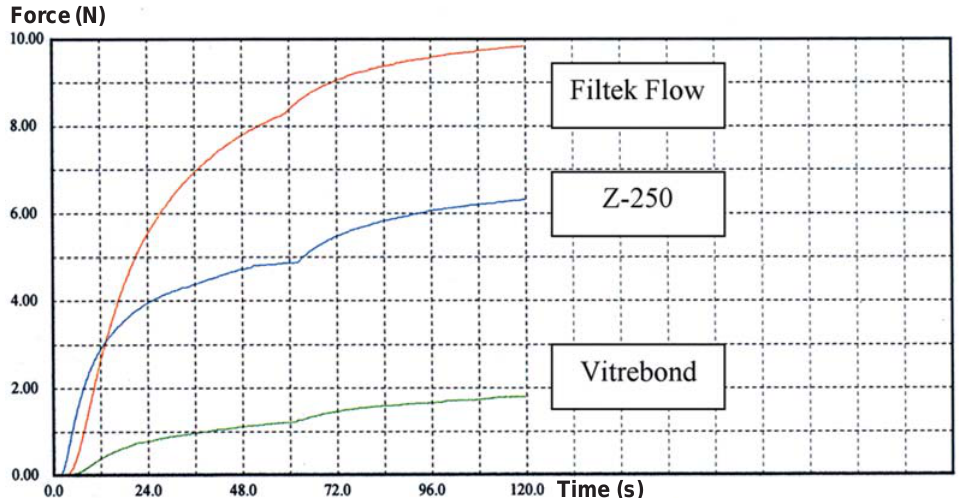
FIGURE 2- Force/time graph obtained for Z-250 resin composite, Filtek Flow flowable composite and Vitrebond resin- modified glass ionomer cement